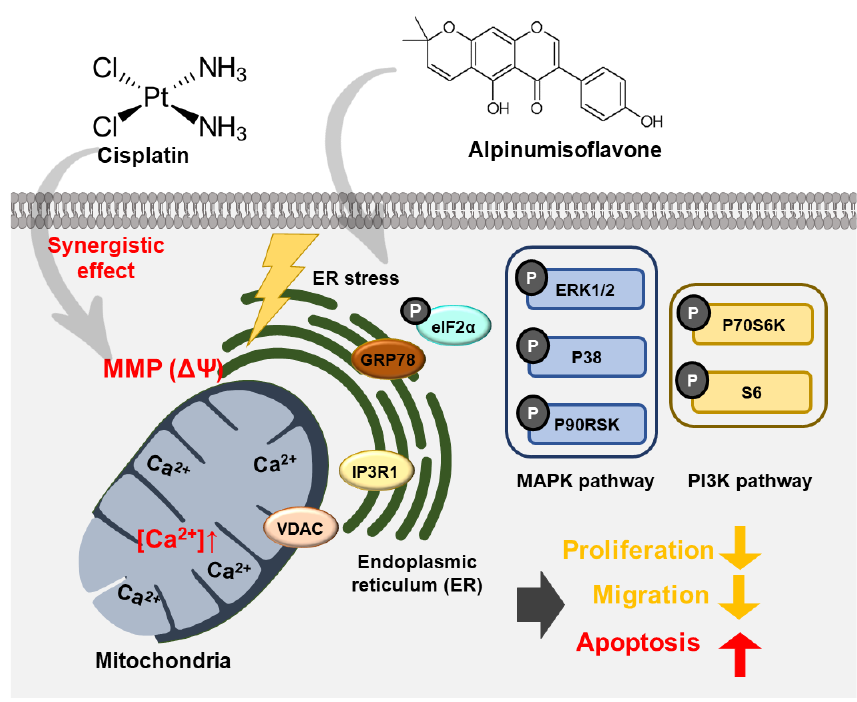
Figure 10. Schematic illustration of possible molecular mechanisms induced by alpinumisoflavone treatment in ES2 and OV90 cells.